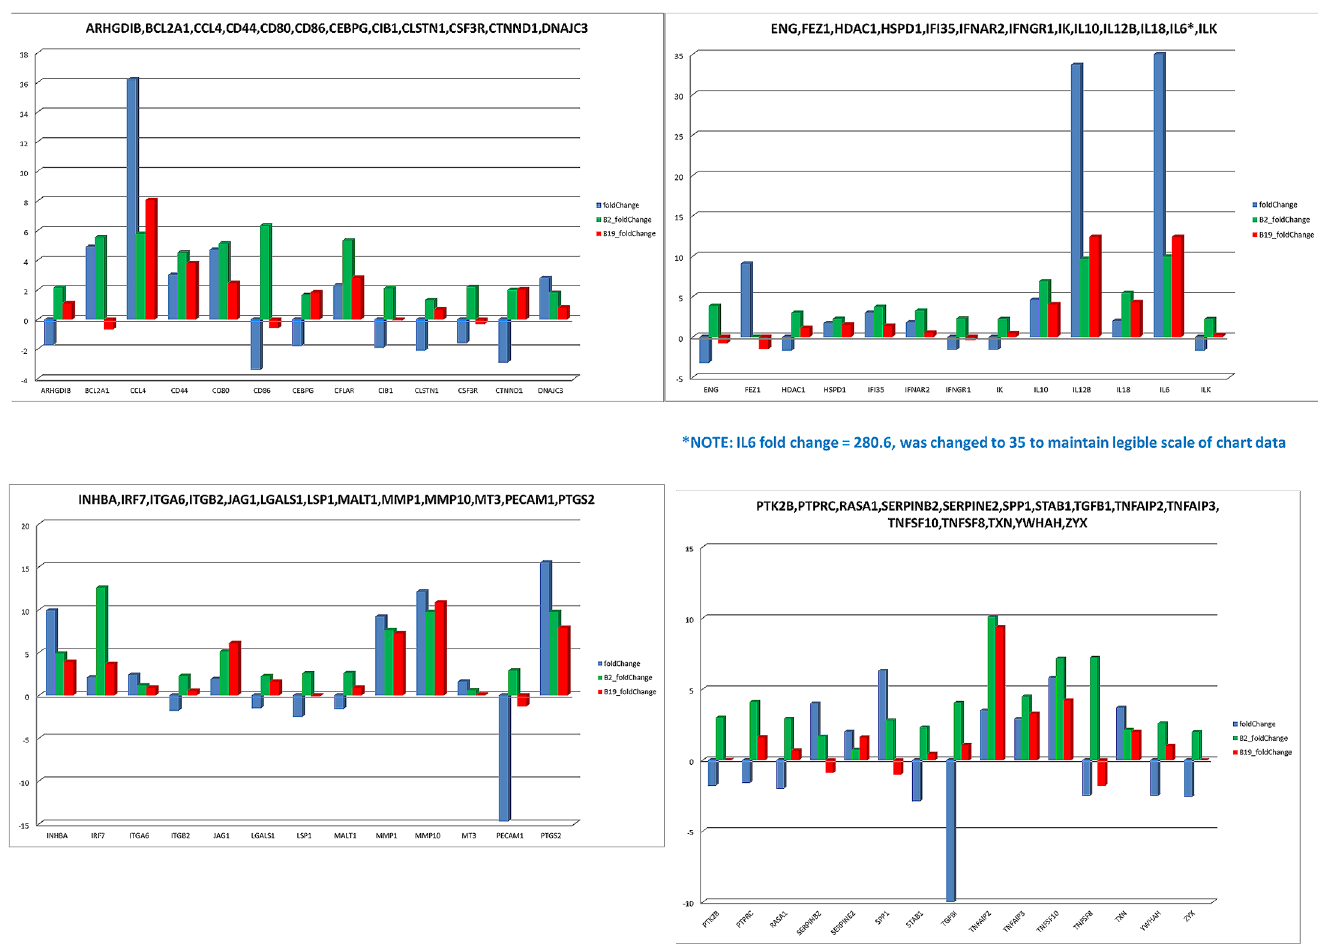
Fig 5. IFN γ stimulated vs. cytomegalovirus stimulated macrophage gene expression. 54 genes, for which gene expressionchangeswere previously describedfollowingcytomegalovirus stimulationwere used as comparisons for the correspondinggenesin the B2 and B19 haplotypebirds. A total of 25 publishedgenesexhibiteddecreases in expressionfollowingcytomegalovirus stimulationwhile29 genes exhibitedincreasedexpression followingstimulation.All but one gene (FEZ1) in the B2 cells exhibitedincreasedexpression followingIFN γ stimulation.In contrast, ten genesdisplayed decreased expressionin the B19 cells. Of the ten exhibiting fold-change < 0 in the B19 cells, seven exhibiteddecreased expressionin the cytomegalovirus stimulatedcells. Twenty-eight genes (52%) expressedin the B2 cells matched the direction of the fold changereportedin the publisheddata while33 genes(61%) correspondedbetweenthe B19 cells and the published data. Of the ten publishedgenesreported as having greater than at least 5-fold increasedexpression, 90% of the B2 genes exhibitedfold-changein the same direction.